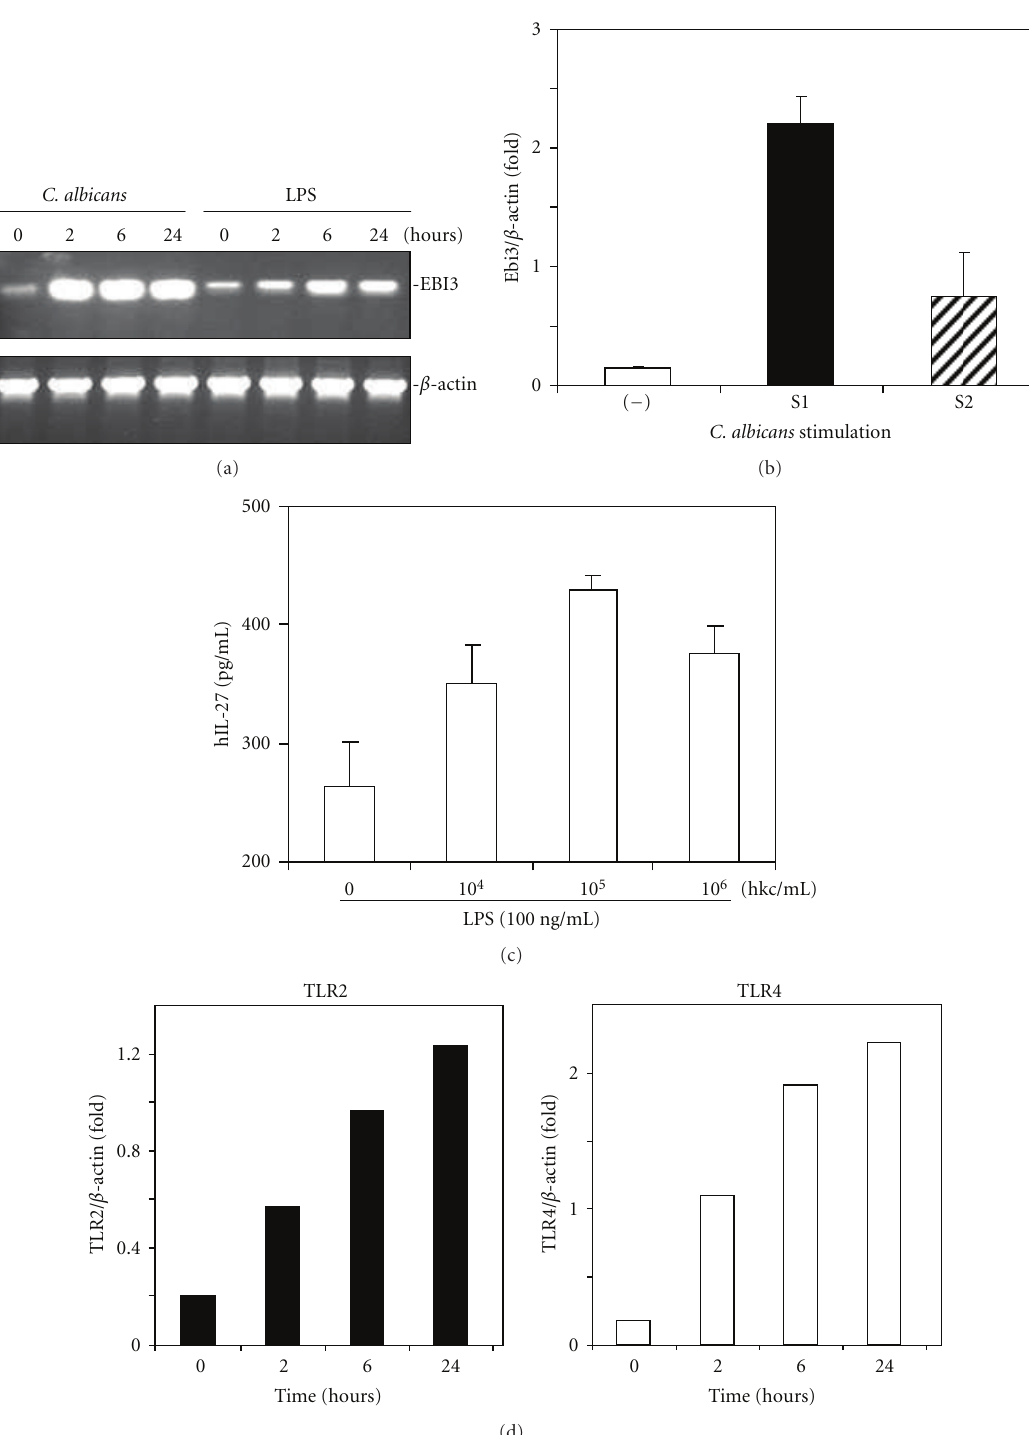
Figure 2: Heat-killed Candida albicans (HKC) stimulated THP-1 cell for Ebi3 and TLR2/4 expression. (a) THP-1 cells were stimulated with 1 × 10 5 HKC /mL and 100 ng/mL LPS for indicated time. The Ebi3 mRNA was detected by RT-PCR. The RNA equal loading was shown by β -Actin RT-PCR. (b) THP-1 cells were stimulated with two clinical strains of C. albicans (S1 and S2) for overnight. The Ebi3 expression was presented by band density ratios of Ebi3 over β -Actin. (c) IL-27 cytokineS were measured by a human IL-27 ELISA (R&D system) in a cell culture with pretreated THP-1 cell with indicated increase density of heat killed Candida followed by low dose LPS stimulation. (d) TLR2 and 4 mRNA expression was increased by 1 × 10 6 HKC